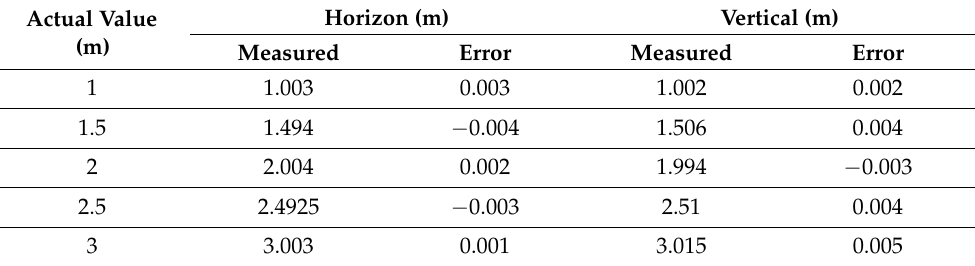
Table 3. Tag recognition performance at 100 m.